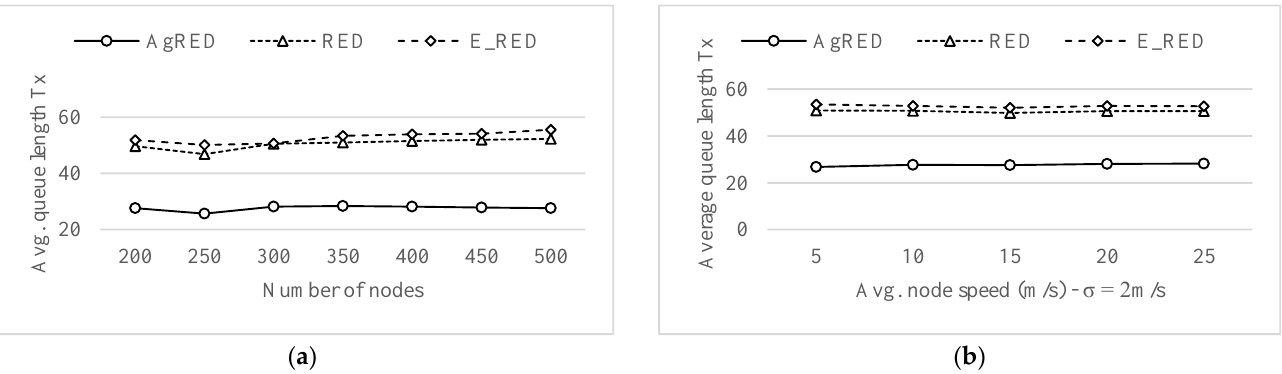
Figure 7. Average queue length of transmitter vs. ( a ) number of nodes and ( b ) average node speed.